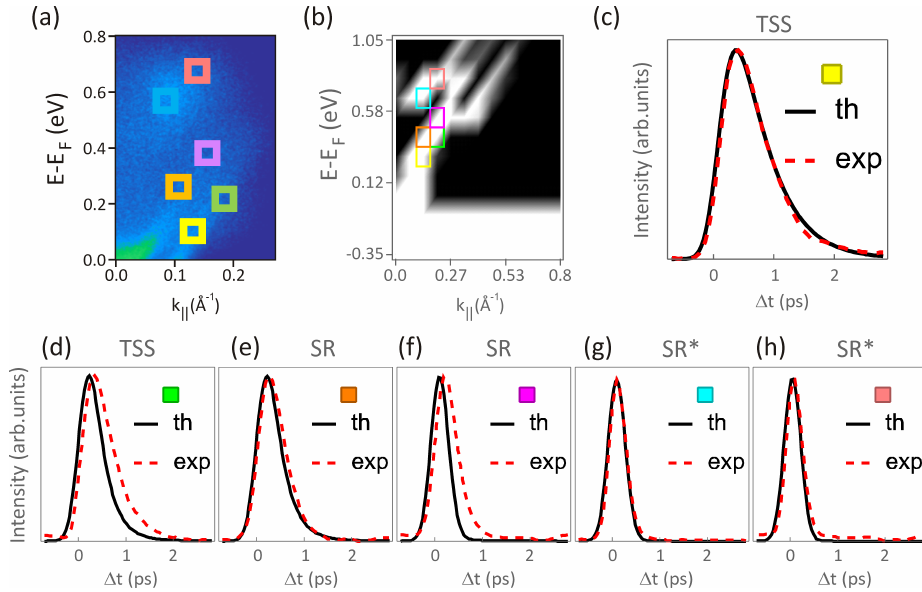
Figure 4. Comparison between the dynamical calculations using the GW +Boltzmann approach and the results of time-, energy-, and momentum-resolved photoemission experiments. ( a ) the band-resolved dynamics was measured by integrating the photoemission intensity within small energy-momentum windows (depicted in various colors among the different states TSS, SR and SR*) as a function of pump-probe time delay ∆ t; ( b ) similar analysis was performed using the discretized GW bands, with the corresponding energy-momentum windows placed at equivalent positions; ( c – h ) normalized intensities obtained as a function of pump-probe delay within the small energy-momentum windows shown in ( a , b ), respectively. Red dashed lines are the experimental spectra, and black solid lines are the corresponding